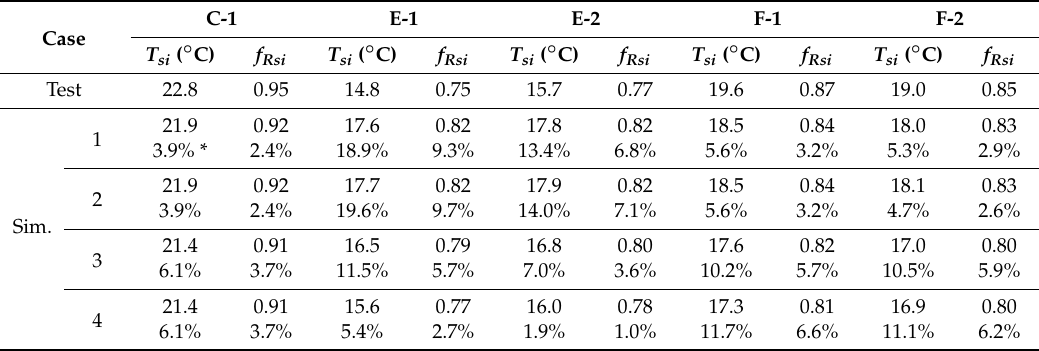
Table 4. Surface temperature and f Rsi from tests and simulations.